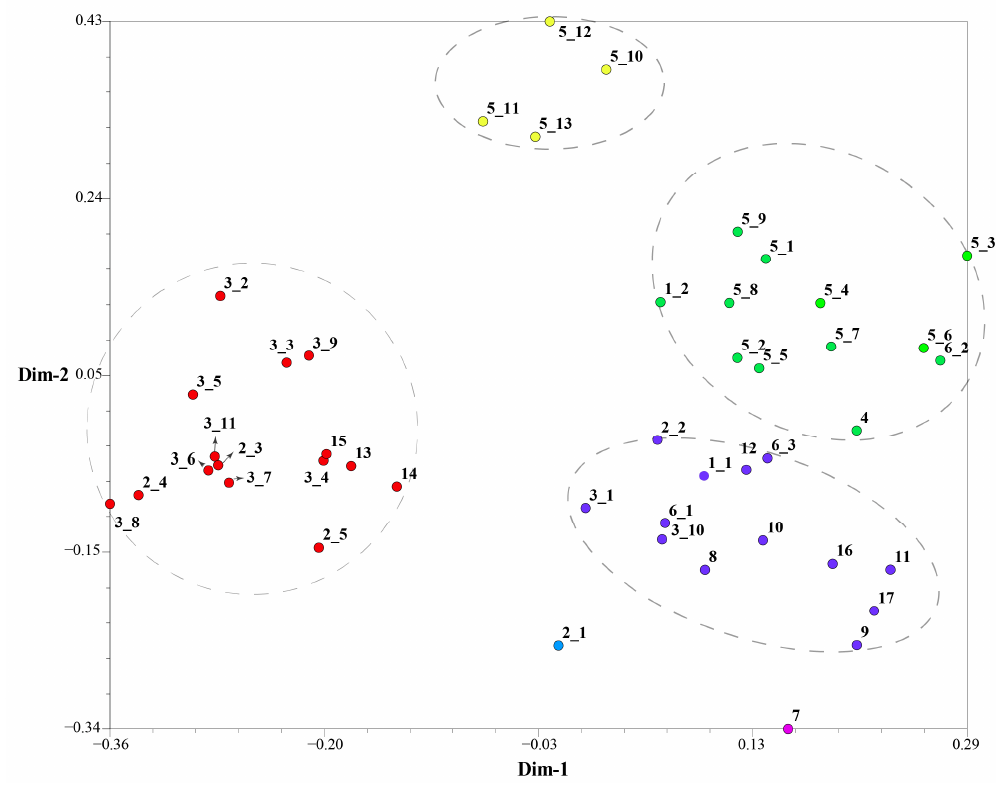
Figure 6. Integrated two-dimensional plot of principal coordinate analysis (PCoA) based on ISSRs and IRAPs of 46 rhododendron accessions. Similar colors represent related groups. Table 2. Genetic variation information of three Rhododendron populations.